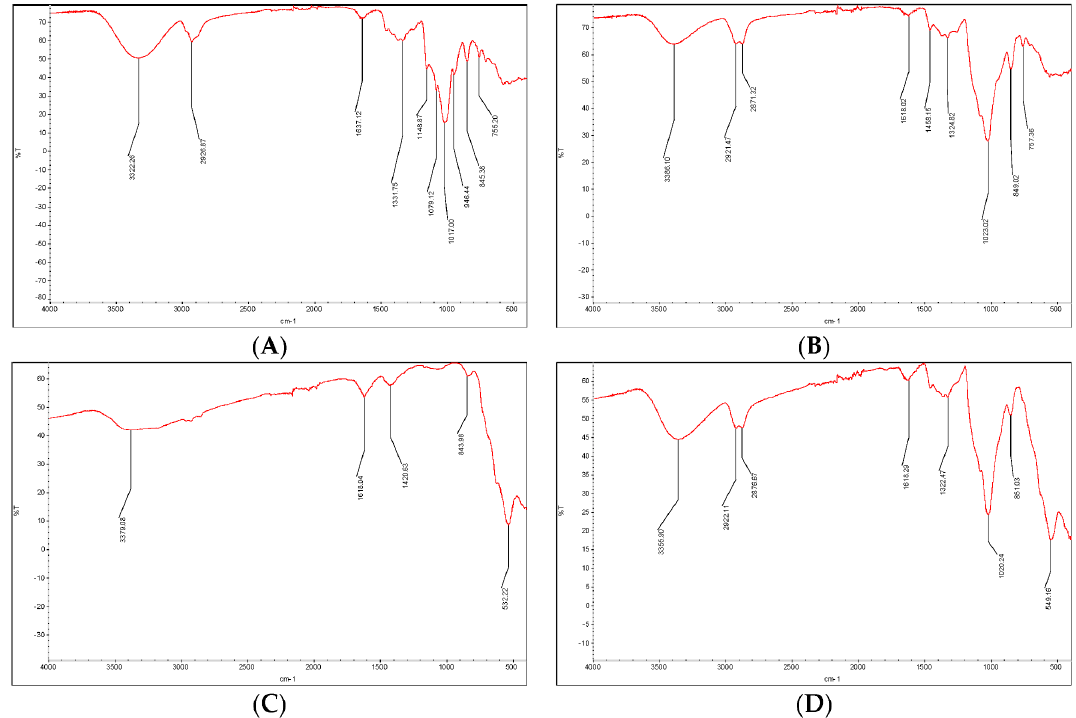
Figure 2. The IR spectra of the ( A ) β -cyclodextrin, ( B ) β -cyclodextrin-epichlorohydrin, ( C ) Fe 3 O 4 nanoparticles, and ( D ) β -CD-EPI polymer-modified Fe 3 O 4 nanoparticles. Deformation C–O–H modes were present at 1500–1200 cm − 1 , stretching C–O–C modes at 1200–850 cm − 1 and other nonspecific C–H deformation peaks below 800 cm − 1 completed the spectrum for cyclodextrin, epichlorhydrin polymerized cyclodextrin, and the iron oxide epichlorhydrin cyclodextrin polymer (Figure 2A,B,D). The incorporation of metallic parti- cles in the core of the β -CD-EPI polymer was proven by the appearance of the most relevant band of the uncoated iron oxide spectrum, the octahedral Fe–O stretching vibration